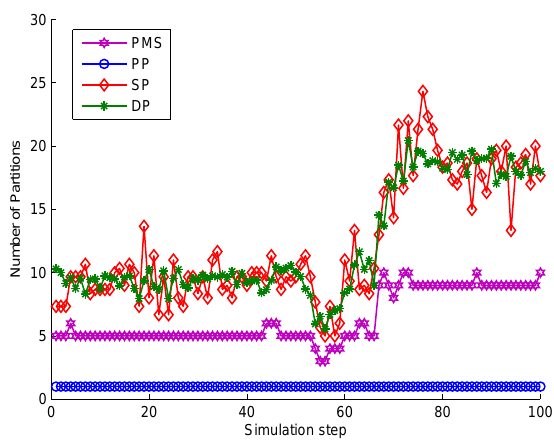
Figure 6. The comparison of four approaches in partitioning number.